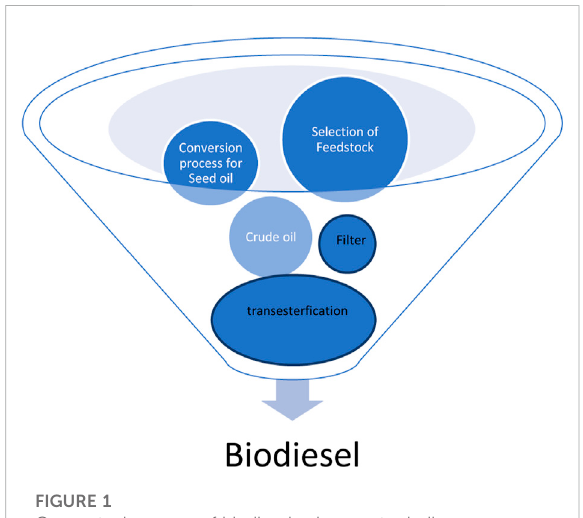
FIGURE 1 Conceptual process of biodiesel using mustard